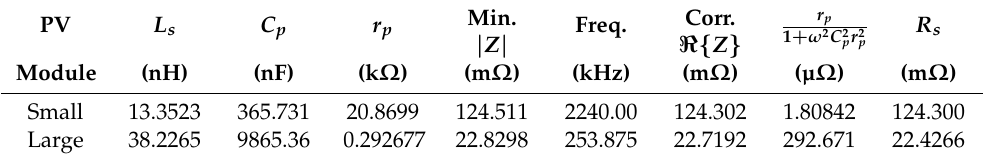
Table 6. Per-cell small-signal AC parameters for the two PV modules. PV L s C